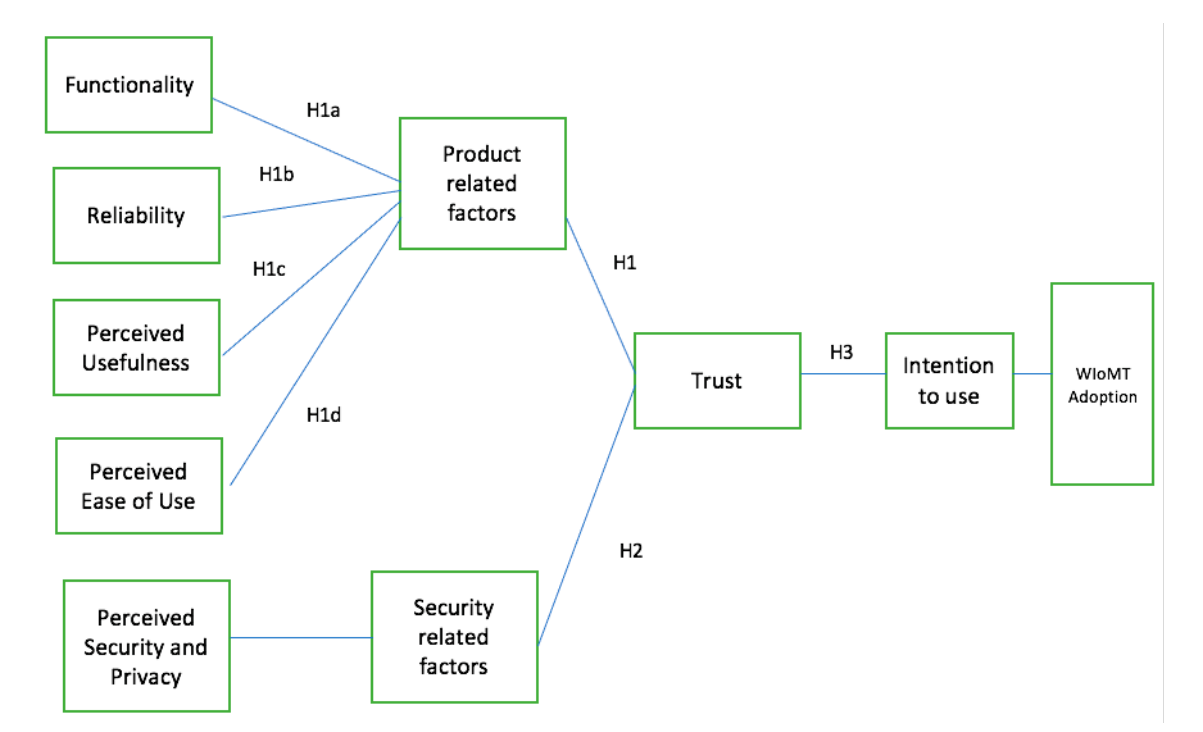
Figure 2. Conceptual Model.